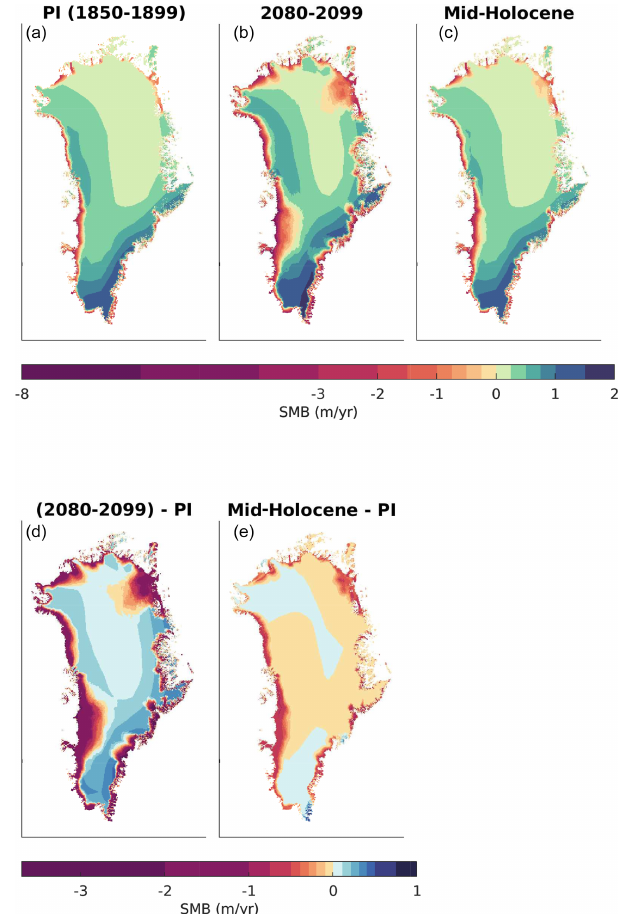
Figure 12. (a–c) Mean SMB of the experiment Industrial during the PI period (years 1850 to 1899, a ), during the 2080 to 2099 period of the experiment Industrial (b) and mean SMB of experiment H6K. (d, e) SMB anomaly with respect to the PI period for the years 2080 to 2099 in the experiment Industrial (d) and for experiment H6K.